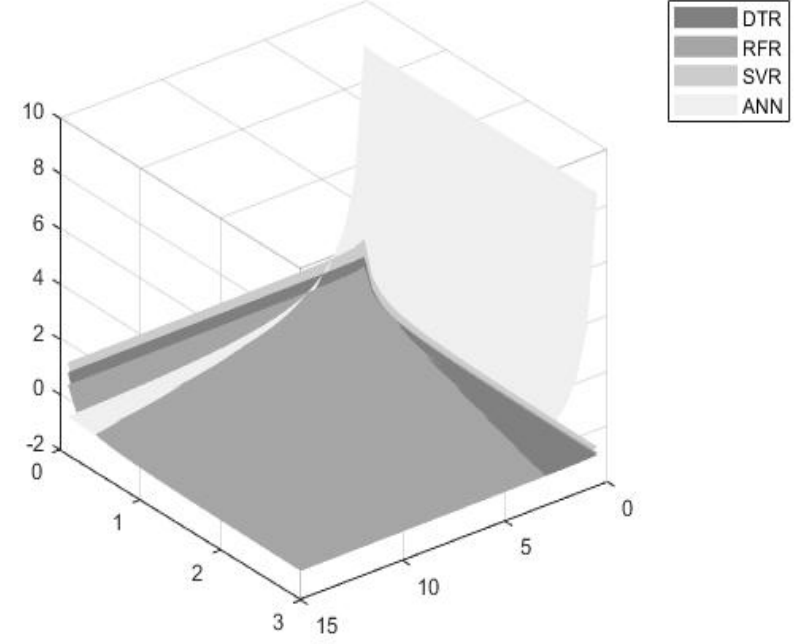
Figure 7. Sensitivity analysis of accuracy and time threshold values with w a = 60%, 1 − w a = 40%